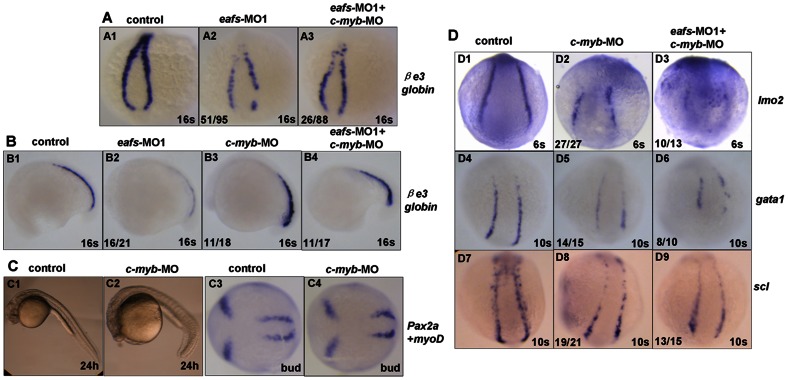

Eafs act upstream of c-myb in primitive hamatopoiesis.(A) In situ hybridization of βe3 globin showing rescue of erythroid differentiation defects in eafs morphants by knockdown of c-myb, the numbers of embryos displayed reduced βe3 globin in total detected embryos was shown in (A2, A3). (B) βe3 globin expression in eafs morphants (B2) and in,c-myb morphants (4 ng per embryo) (B3) and in morphants injected with combined eafs-MO and c-myb-MO (8 ng eafs-MO per embryo and 2 ng c-myb-MO) (B4). (C) Morphology of representative embryos injected with c-myb-MO (C2), and mesoderm pattern indicated by expression of pax2a and myoD in c-myb morphants at the bud stage (C4). (D) C-myb function downstream of eafs in primitive hematopoiesis. Early hematopoietic progenitors, lmo2, displayed obviously reduced expression from the 6 somites stage both in c-myb morphants (4 ng per embryo) (D2) and in morphants injected with combined c-myb-MO and eafs-MO (8 ng eafs-MO/per embryo and 2 ng c-myb-MO) (D3). Gata1 and scl also displayed obviously reduced expression in embryos injected with combined eafs-MO and c-myb-MO (D6, D9) as in embryos injected with c-myb-MO single (D5, D8) at the 10 somites stage. A1–A3, D1–D9, dorsal view, anterior to the up; C3, C4, dorsal view, anterior to the left. B1–B4, C1, C2, lateral view, anterior to the left.